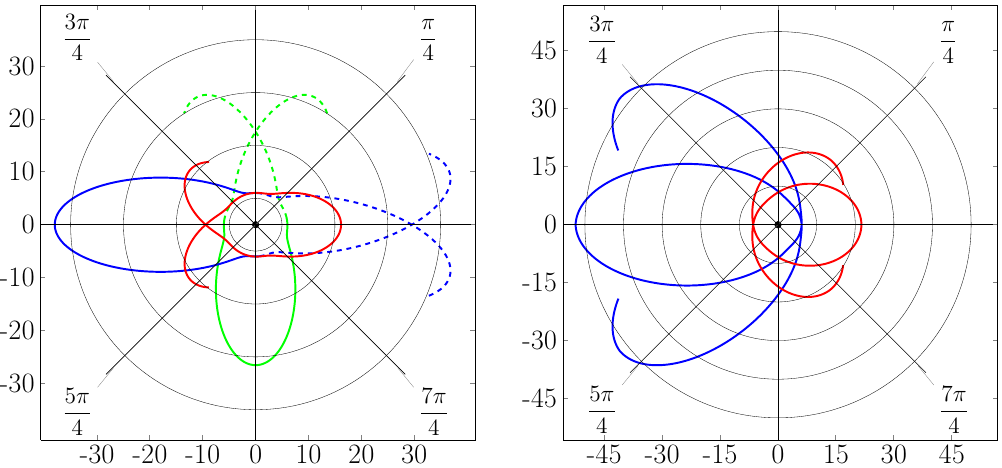
Figure 4. The shapes of some precessing trajectories of massive test particles for ansatz (28) with a = 9. Left panel ( J = 2): E 2 = 0.89, ∆ ϕ = ∆ ϕ = 2.89 (blue line). The dashed parts of lines represent the parts of trajectories located in the region − r < 0. Right panel ( J = 3): E 2 = 0.925, ∆ ϕ =